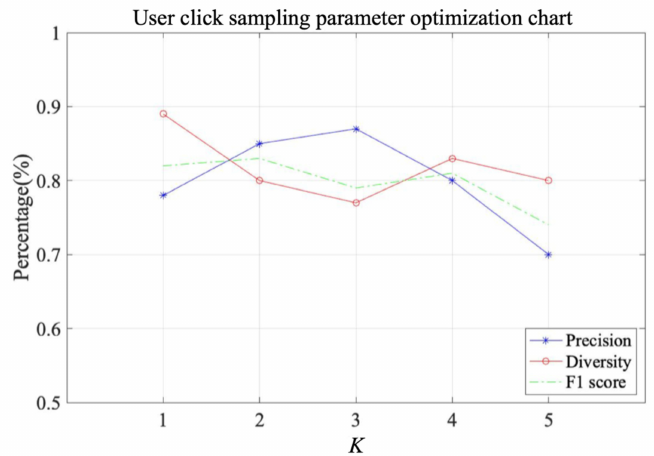
Figure 10. User click sampling parameter optimization